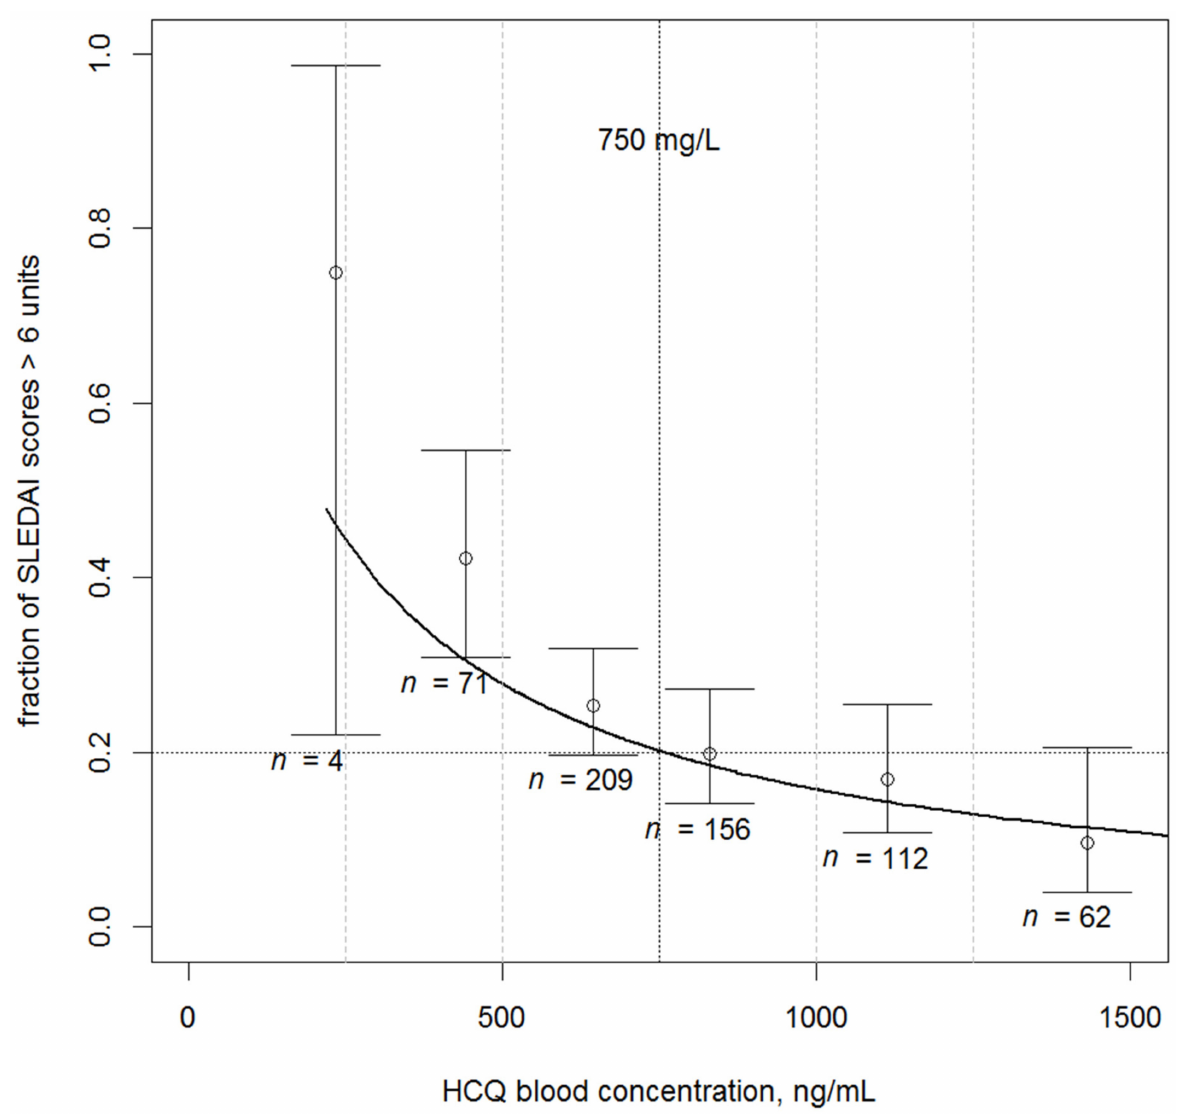
Figure 2. Observed and model-predicted percentages of scores > 6 units as a function of blood HCQ concentrations. Note that the 750 ng/mL threshold is associated with a 20% risk of active disease status. Open circles and segments, observed percentages with their 95% confidence intervals; black curve, median prediction; vertical dashed lines denote the concentration intervals for percentage